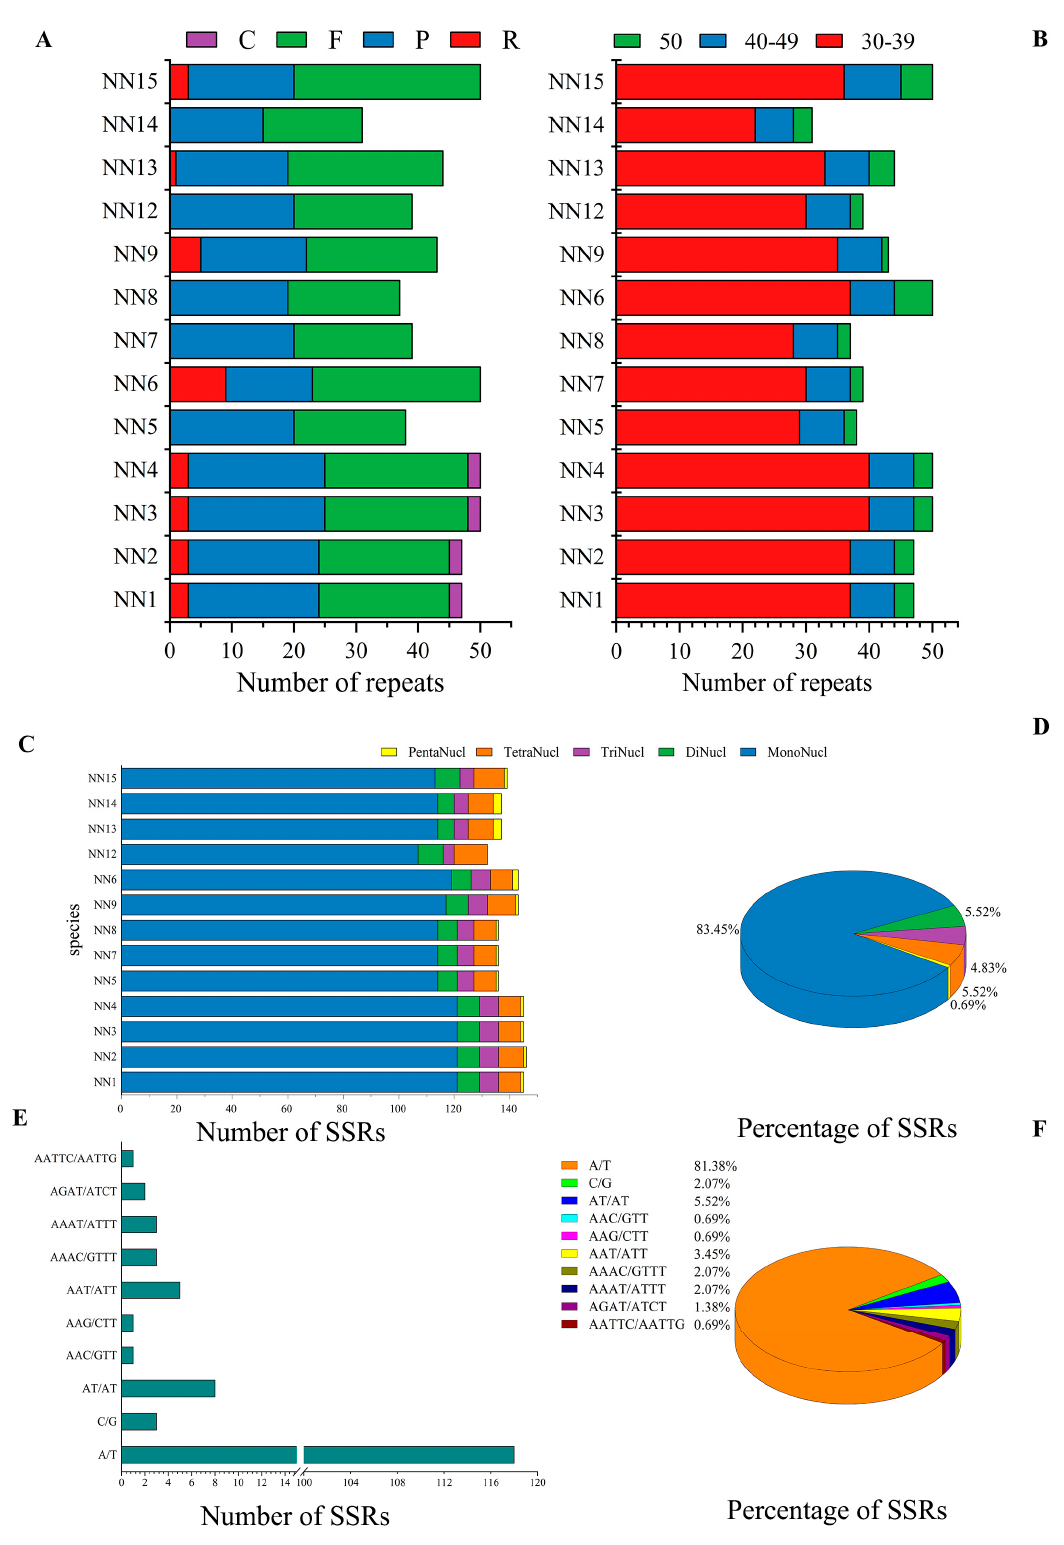
Figure 3. Repeat sequences and SSRs in 13 cp genomes. ( A ) F, P, R, and C indicate the repeat types F (forward), P (palindrome), R (reverse), and C (complement), respectively; ( B ) Repeats with different lengths. ( C ) Repeat unit and amounts of SSR in thirteen cp genomes. ( D ) Percentage of different SSR types in the NN1 cp genome. ( E ) SSR repeat sequences in the NN1 cp genome. ( F ) Percentage of repeated sequences in the NN1 cp genome.